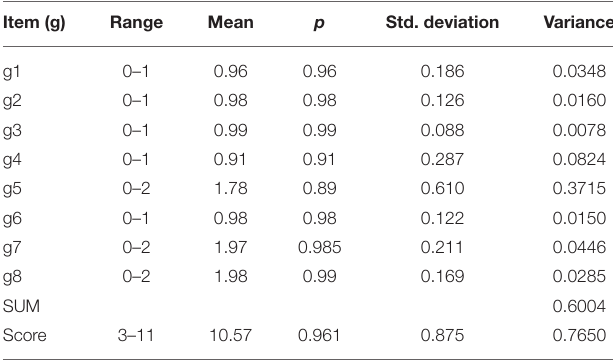
TABLE 3a | Descriptive statistics of the test items from Metsämuuronen and 7,770). Ukkola (2019) ( N =